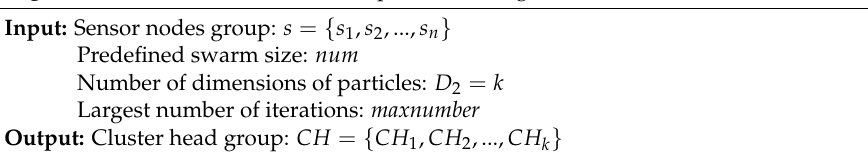
Algorithm 4: Cluster head selection optimization algorithm based on